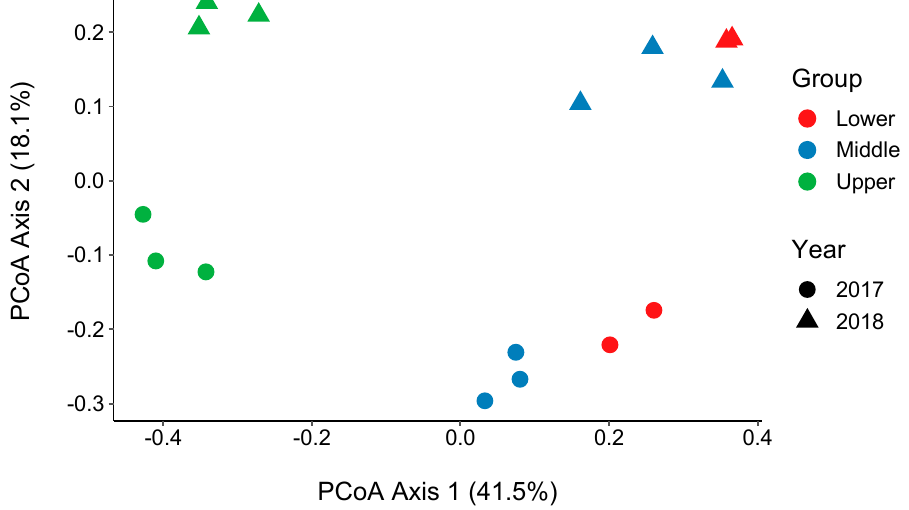
Figure 3. Principal coordinate analysis (PCoA) plots showing the Bray–Curtis dissimilarities among the bacterial communities. Sites were divided into three groups based on the land-use patterns: the upper sites (S1–S3), the middle sites (S4–S6), and the lower sites (S7 and S8).